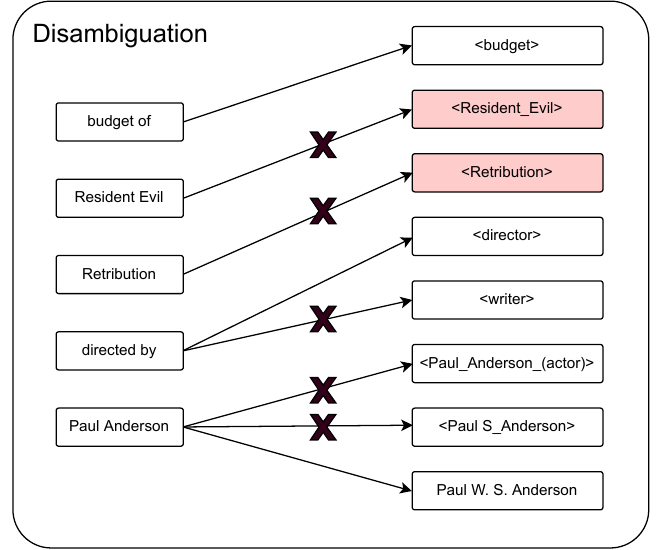
Figure 6. The partial candidate list of example